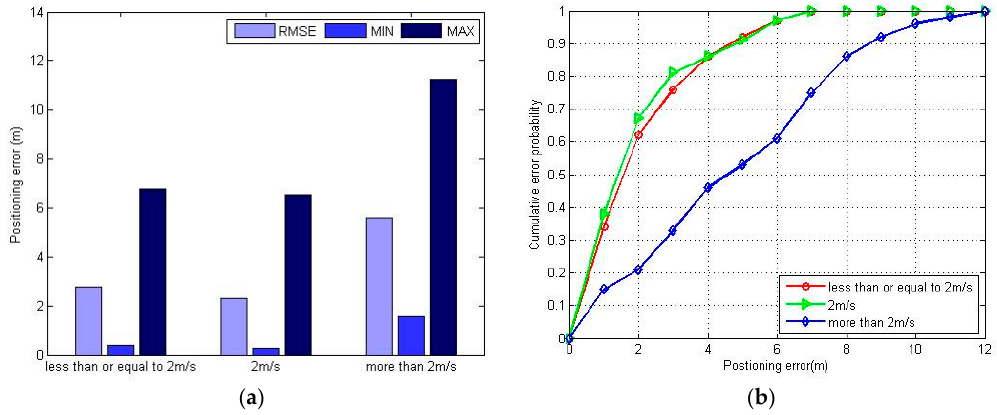
Figure 12. The positioning error under uniform and variable speed using FPR algorithm: ( a ) maximum positioning error, minimum positioning error and RMSE at uniform and variable speeds; ( b ) CDF at uniform and variable speeds.